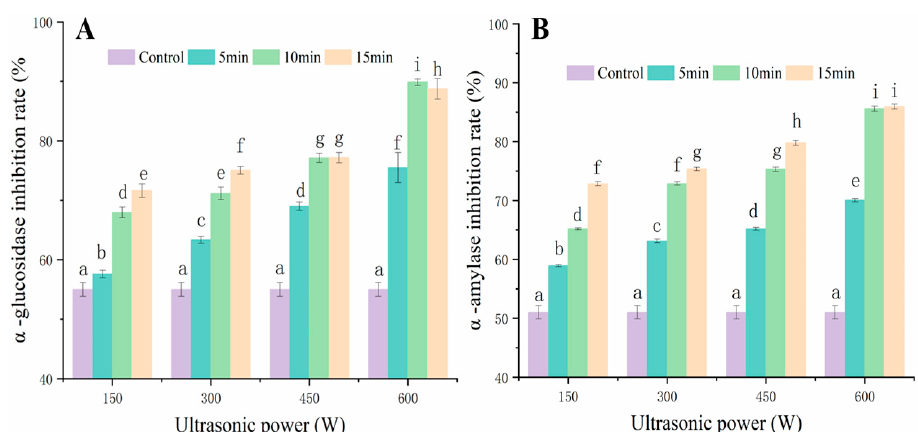
Figure 6. Effect of UAVD treatment on α -glucosidase ( A ) and α -amylase ( B ) inhibition capacity of FSI. Different letters in the histogram indicate that the extraction time points within UAVD are significantly different ( p < 0.05).